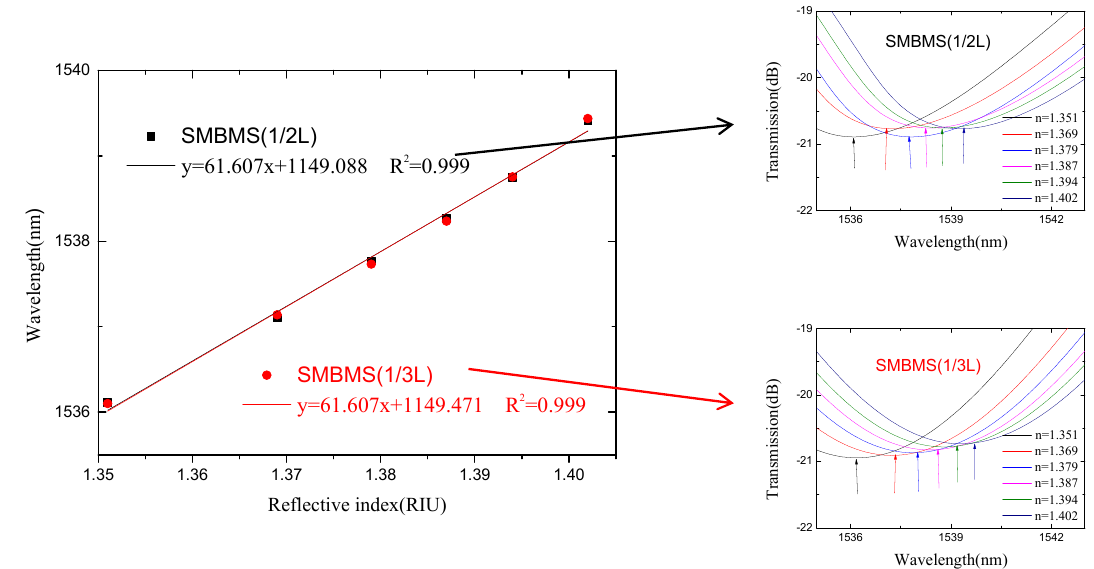
Figure 16. The sensitivity response characteristic diagram of SMBMS MZI.